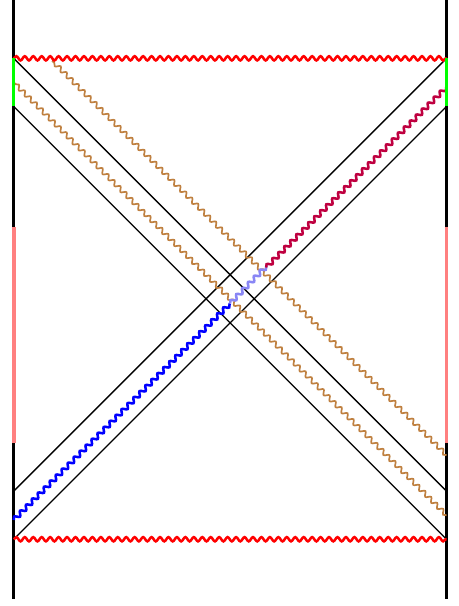
Figure 7 . The full bulk teleportation with additional matters thrown into the horizon from the right side. The teleportee will be a(cid:11)ected by this bulk encounter. Again the shape of the upper singularity is not precise as it may be curved in